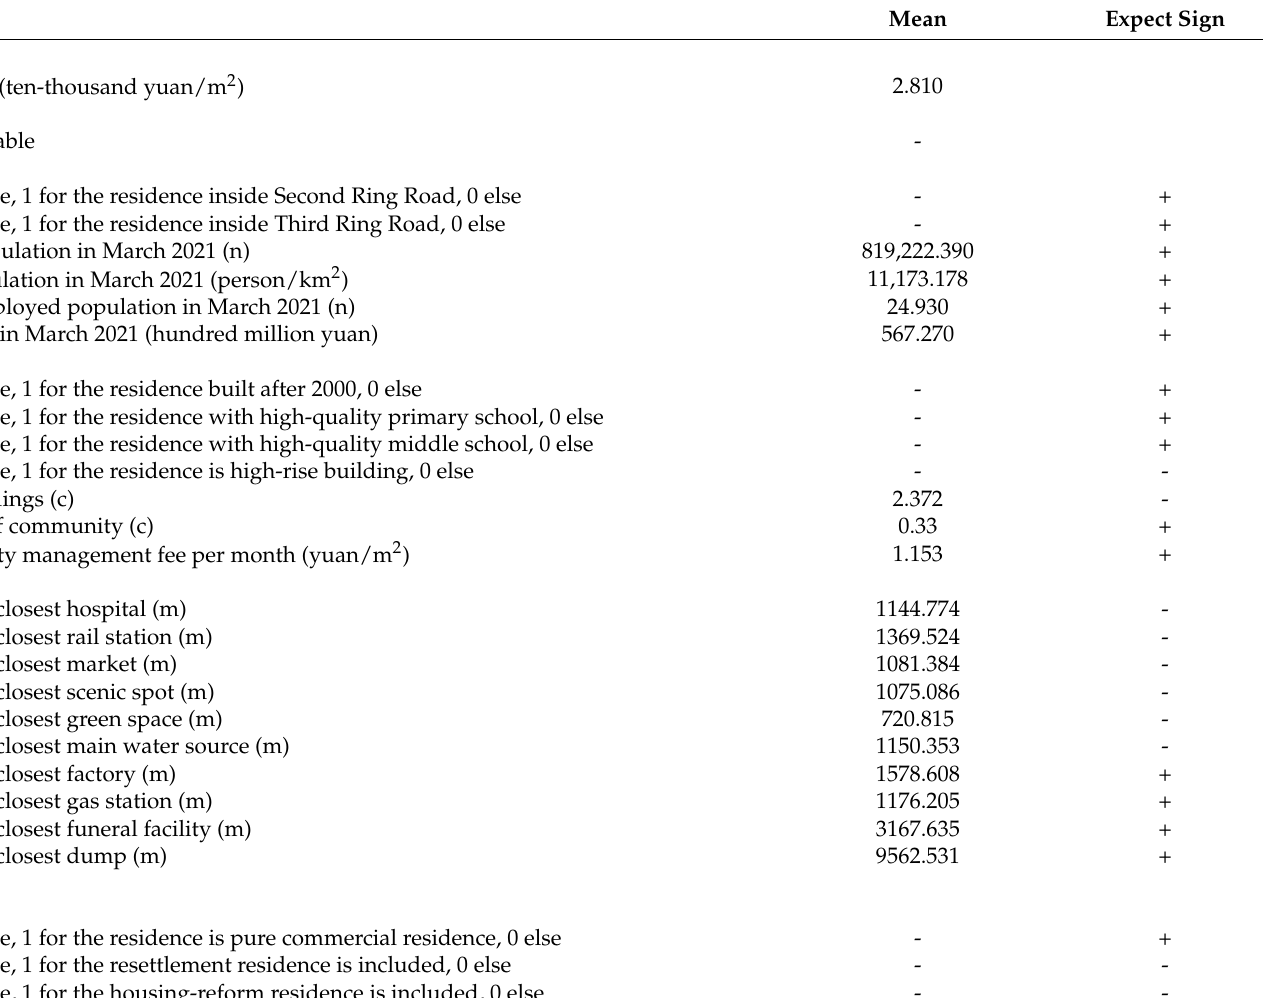
Table 1. Descriptive statistics of the variables (N =